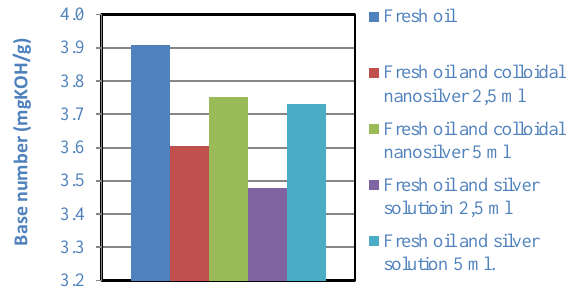
Fig. 6.Base number of fresh oil and fresh oil with colloidal nanosilver and silver